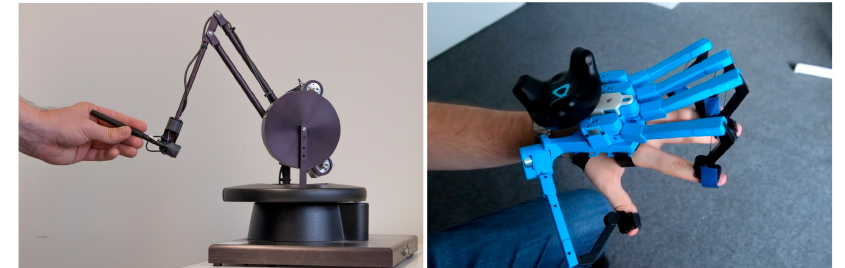
Figure 1. Example to distinguish between grounded and wearable haptic feedback following the differentiation from [14]. On the left side one can see a grounded force feedback device ( Sensable Phantom ), and on the right side a wearable force feedback ( SenseGlove ). With the latter, the users’ hand is more flexible, but is not prevented from accidentally moving inside a virtual object.